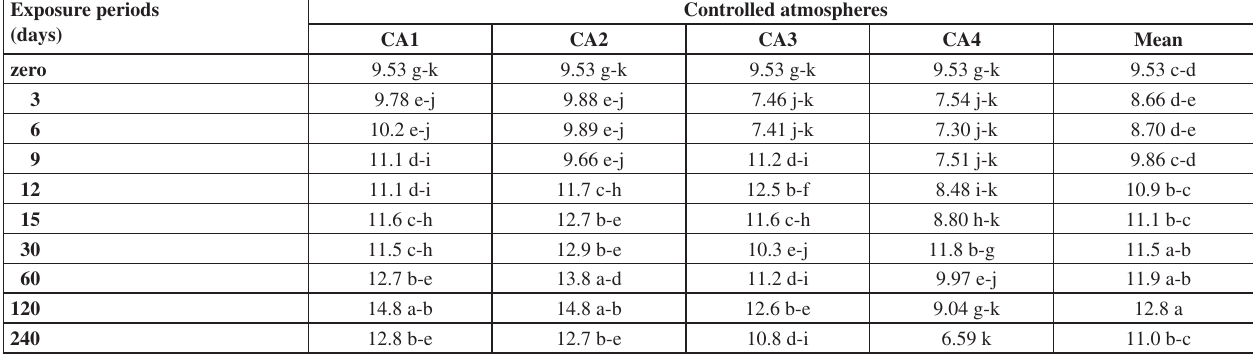
Table 4: Effect of exposure period and different controlled atmospheres on peroxidase activity of onion seeds stored for 12 months Exposure periods